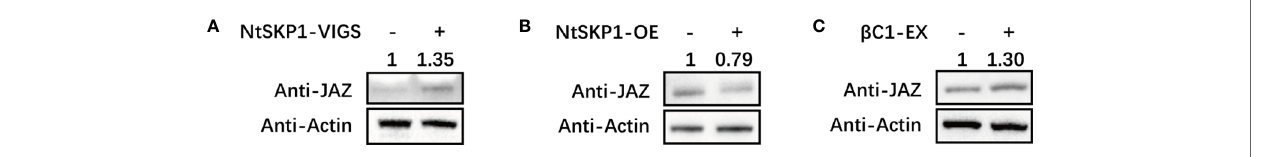
FIGURE 5 | NtSKP1 and b C1 interfere the degradation of JAZ1 protein. (A) Western blot assay of JAZ1 protein in NtSKP1 -silenced (NtSKP1-VIGS) tobacco plants. Gene silencing was achieved by VIGS assay. (B) Western blot assay of JAZ1 protein in NtSKP1 -overexpressed (NtSKP1-OE) tobacco plants. GFP or NtSKP1-GFP fusion proteins were transiently expressed in N. tabacum var. NC89 for 48 h. (C) Western blot assay of JAZ1 protein in b C1 -expressed ( b C1-EX) tobacco plants. YFP C or b C1-YFP C fusion proteins were transiently expressed in N. tabacum var. NC89 for 48 h. Total plant protein extracts were analyzed via SDS-PAGE and western blot assays using anti-JAZ antibodies. Actin was the internal reference. Intensity was detected by image